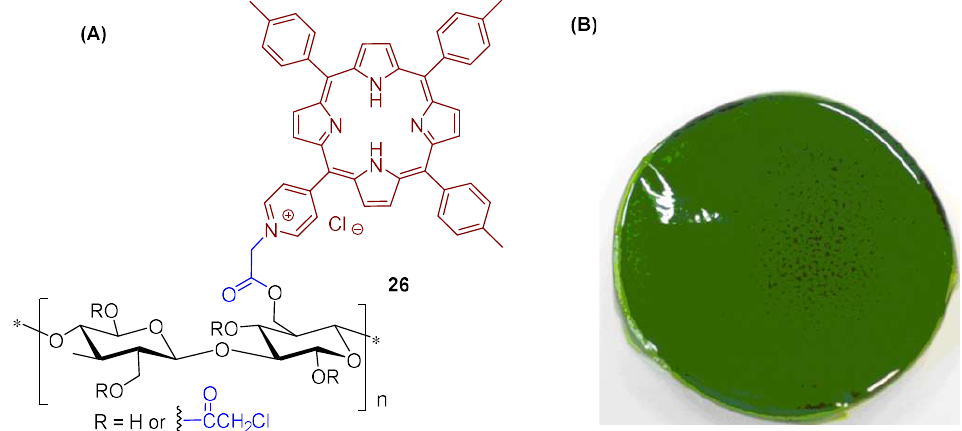
Figure 19. ( A ) Structure of material 26 used by Krausz and co-workers [165] as photobactericidal materials. ( B ) Porphyrinic plastic film prepared. Reprinted with permission from Ref. [165]. 2008